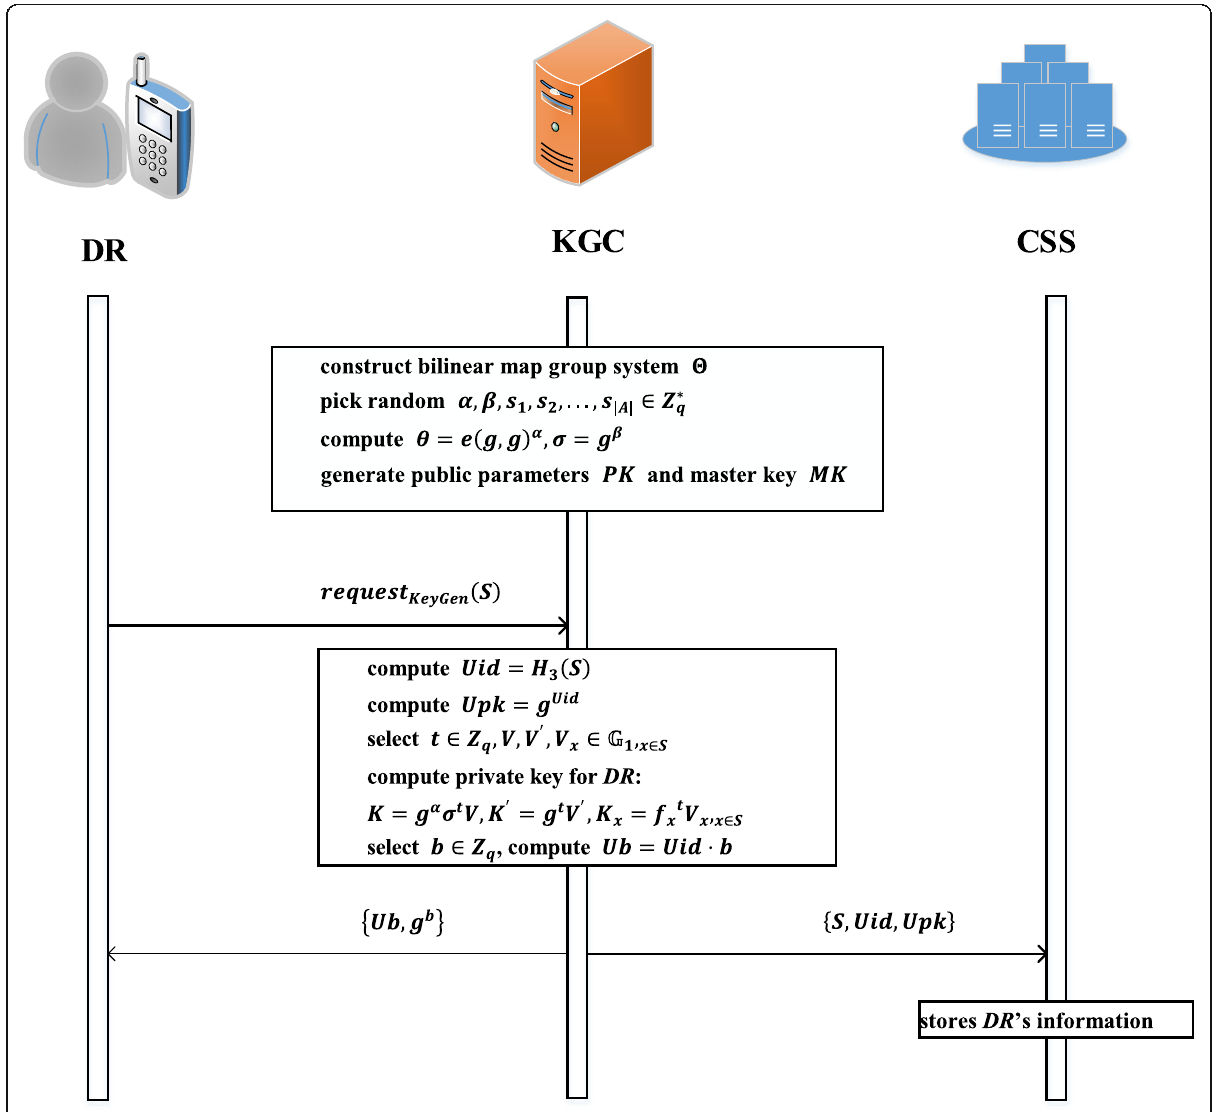
Fig. 2 Dataflow of Initial